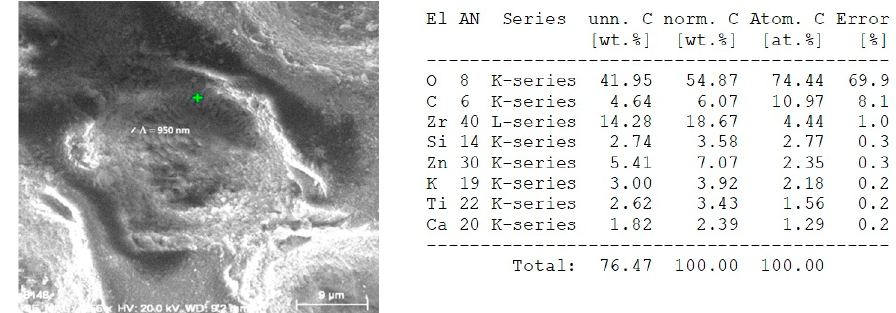
Figure 9. EDX analysis of 70% Ch/30% HAp/ZrO 2 substrate treated with N = 10, I = 7.9 × 10 15 W/cm 2 ; table (right): EDX analysis showing the atomic percentages of O, C, Zr, Si, Zn, K, Ti, Ca.